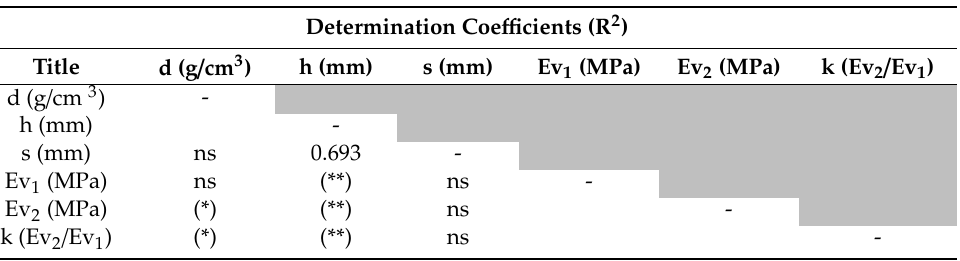
Table 19. Granite rockfill in crown significance